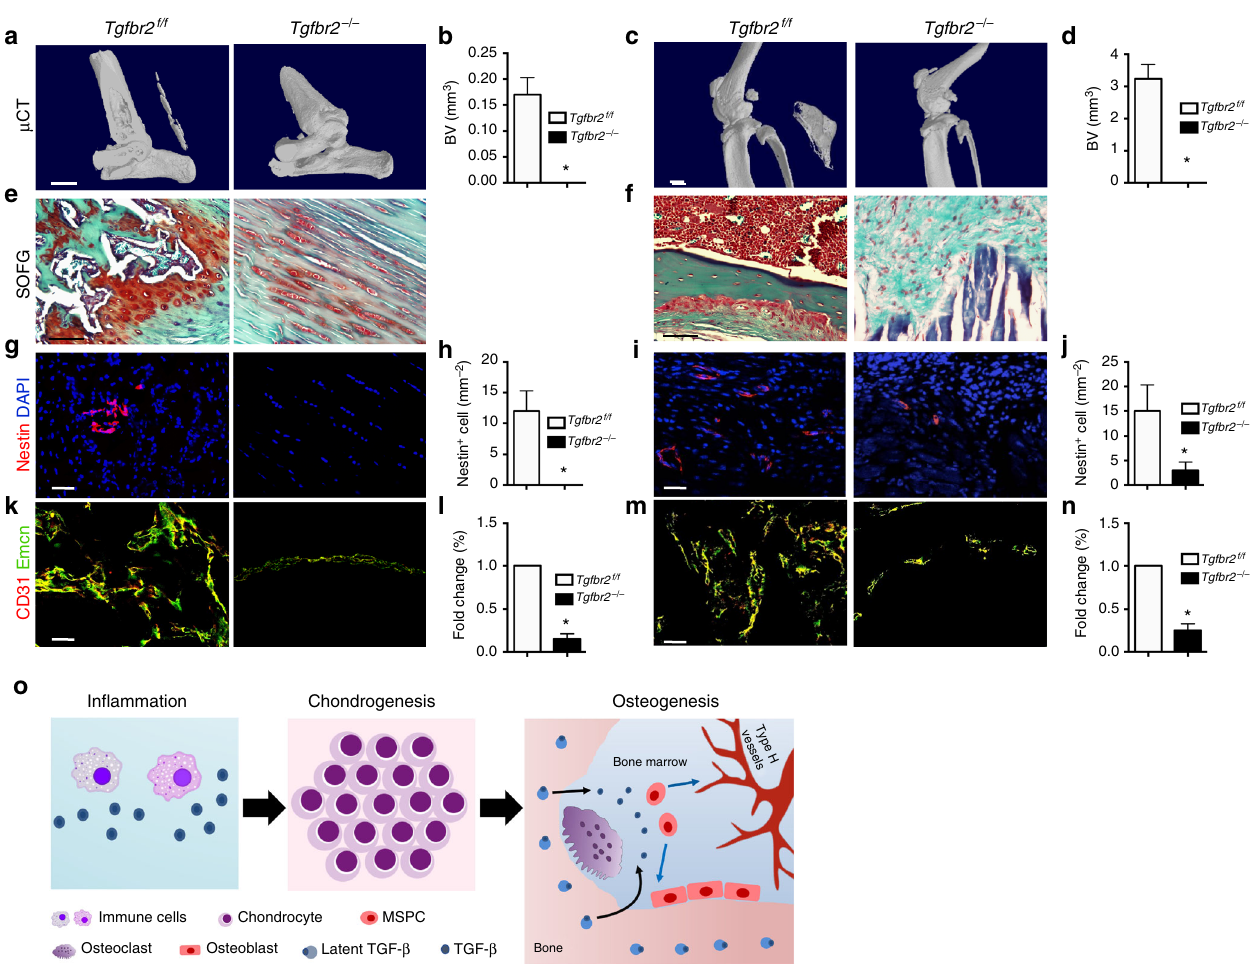
Fig. 7 Inducible knockout of Tgfbr2 in Nestin + cells attenuates HO formation in ATP and BGI mice. a , c Micro CT images and b , d quanti fi cations of a , b Achilles tendons or c , d hamstring muscles of Nestin-creERT2::Tgfbr2 fl ox/ fl ox mice 2 months treated with vehicle or tamoxifen after undergoing ATP or BGI surgery, respectively. Scale bar, 2 mm. e , f SOFG staining of e Achilles tendons or f hamstring muscles of Tgfbr2 fl ox/ fl ox and Tgfbr2 − / − mice 2 months after ATP or BGI, respectively. Scale bar, 50 μ m g , i Nestin + (red) cells in the ectopic bone marrow and h , j quanti fi cations of Tgfbr2 fl ox/ fl ox and Tgfbr2 − / − mice after ATP or BGI, respectively. Scale bar, 50 μ m. Blue indicates DAPI staining of nuclei. k , m CD31 + (red) and Emcn + (green) cells in the ectopic bone marrow and quanti fi cations of Tgfbr2 fl ox/ fl ox and Tgfbr2 − / − mice after ATP or BGI. Scale bars, 100 μ m. Yellow indicates type H vessels. a – n n = 8 per group. All data are shown as the mean ± s.d. * p < 0.05 as determined by two-tailed, unpaired Student ’ s t- test. o Hypothetical diagram of HO formation. After HO induction, abundant immune cells are in fi ltrated in the injury sites and produce TGF- β . Next, the chondrocytes proliferate and undergo hypertrophy